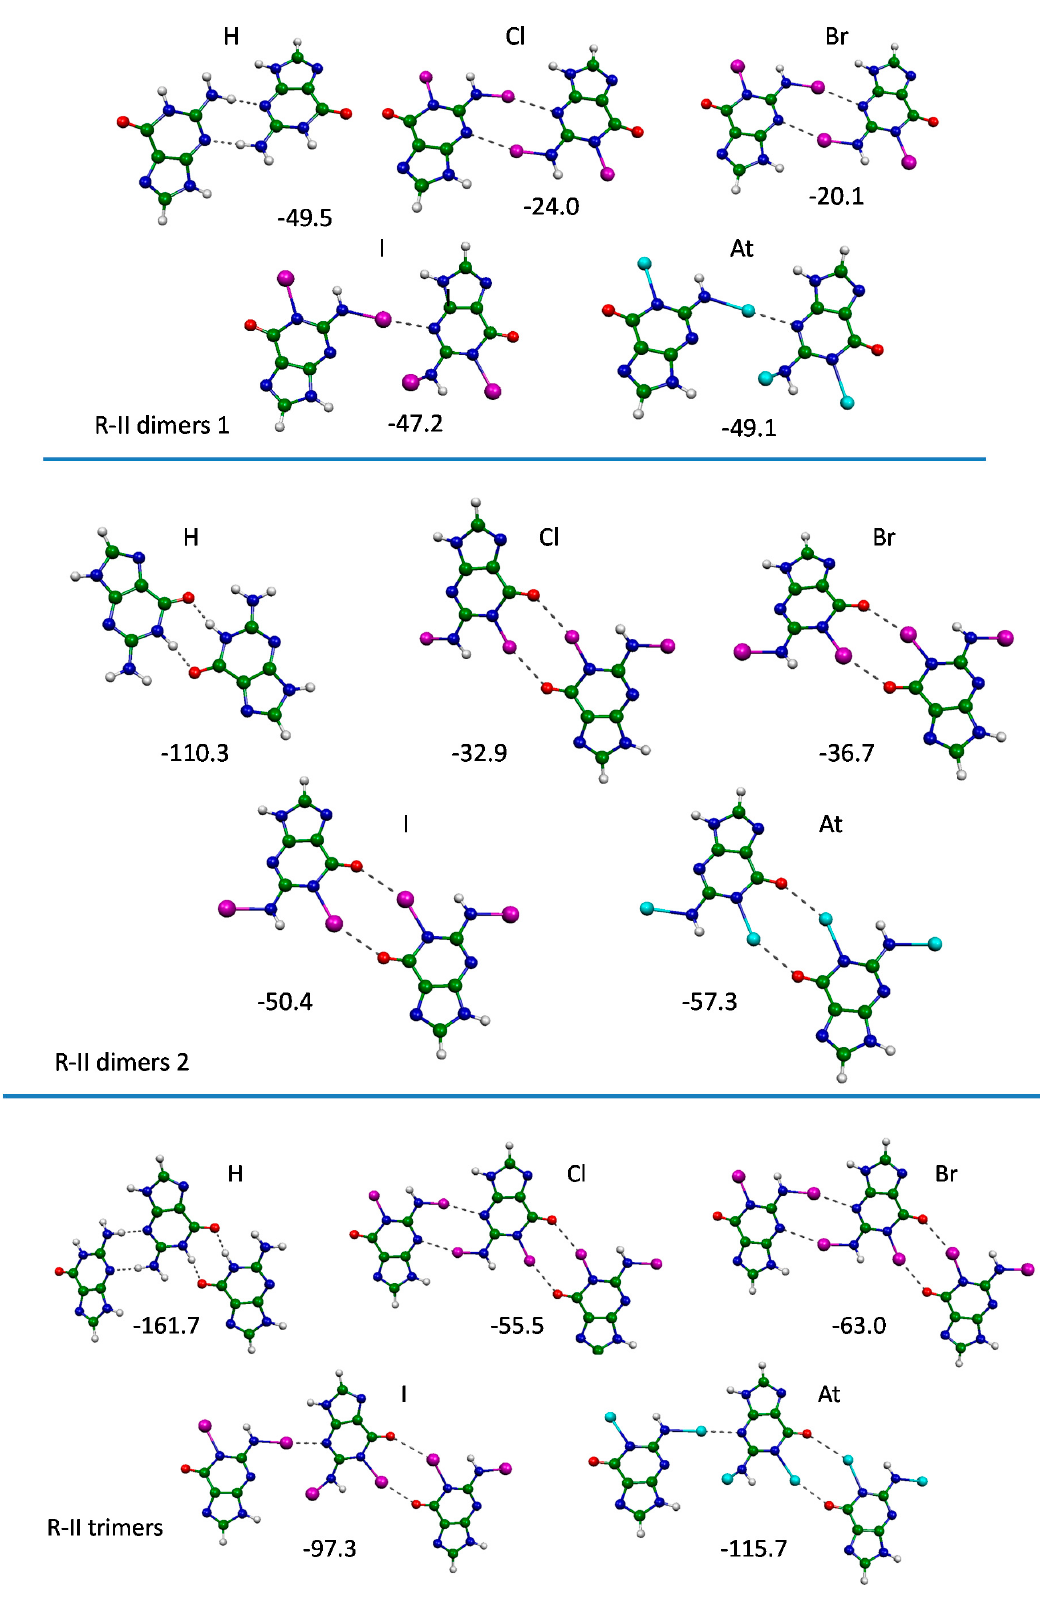
Figure 3. Optimised structures of the 1,2X-G ••• 1,2X-G ribbon II dimers and trimers (X = H, Cl, Br, I, At), with their interaction energies (in kJ/mol).